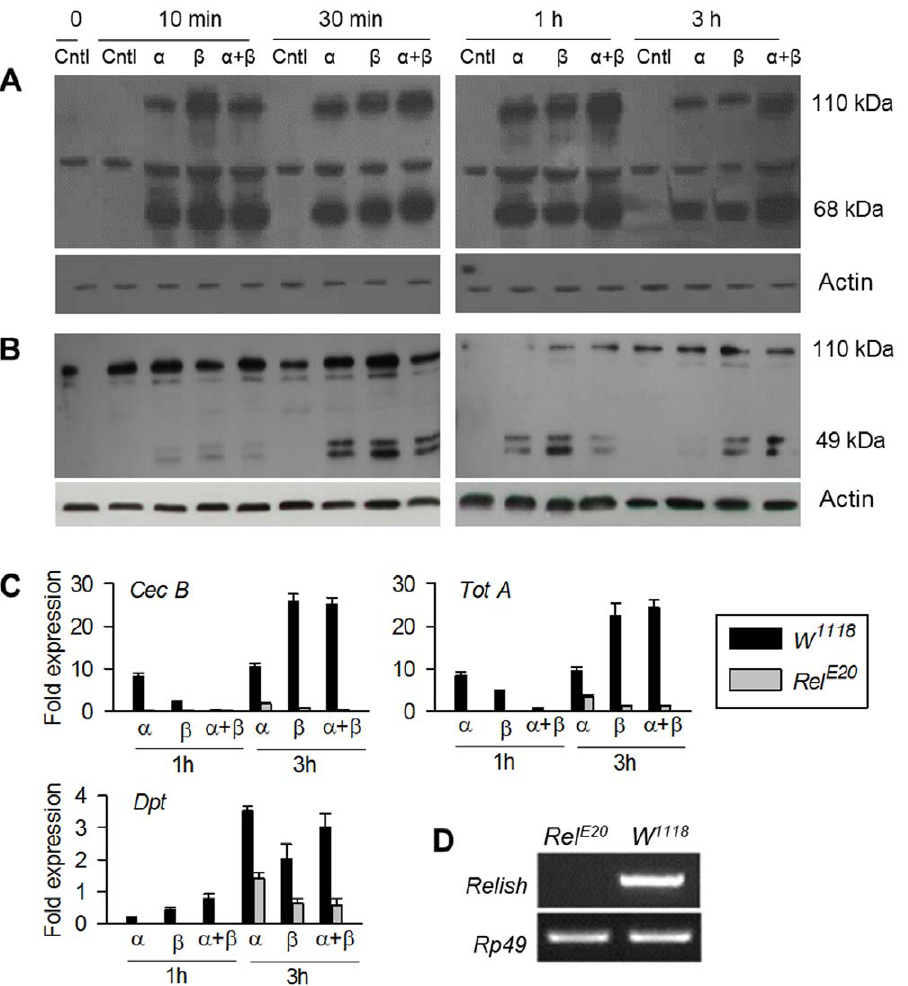
Figure 6. Western blot analysis of NF- k B transcription factor Relish activation in wild type larvae and adults. (A) Neck ligated flies were treated with indicated r-burs a 2 b , burs a 2 a , burs b 2 b or blank vector transfected sample. After the indicated incubation periods the flies were homogenized and then subjected to Western blot analysis using anti-Relish polyclonal antibodies. Bands labeled actin show protein loading controls. (B) Third instar larval fat body preparations were treated with the indicated bursicon proteins. After incubation for the indicated times the FB preparations were homogenized and subjected to Western blot analysis using anti-Relish monoclonal antibody. (C) qPCR analysis of 3 representative genes in the wild type and Relish mutant Rel E20 flies. (D) RT-PCR analysis shows the presence of Relish transcripts in the wild type controls, but not the mutant Rel E20 . The histograms show the means 6 SEM, n=3 biologically independent experiments. Actin loading controls are present in the bottom of A and B.